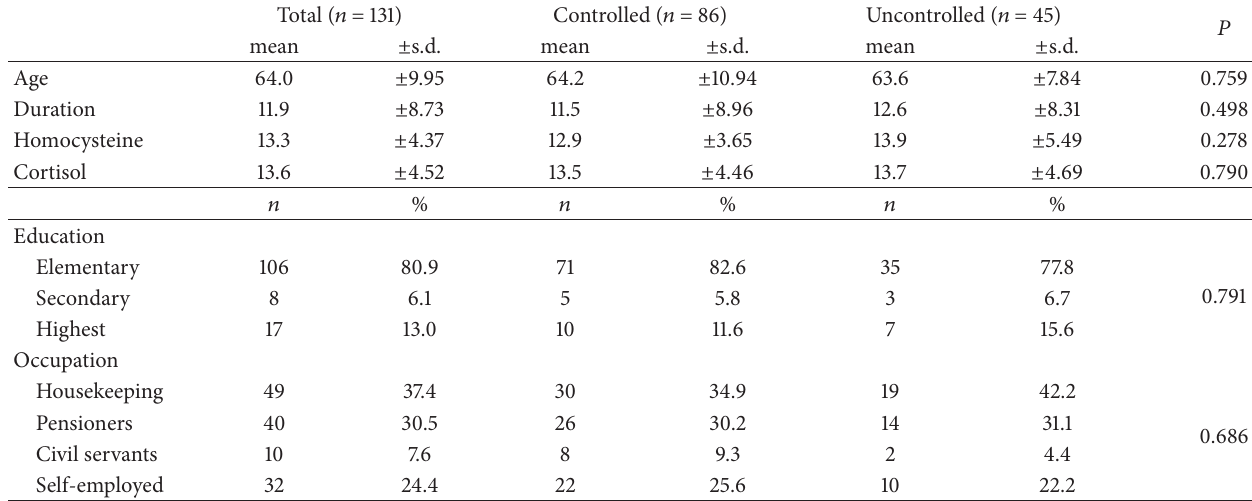
Table 1: Demographic characteristics of the